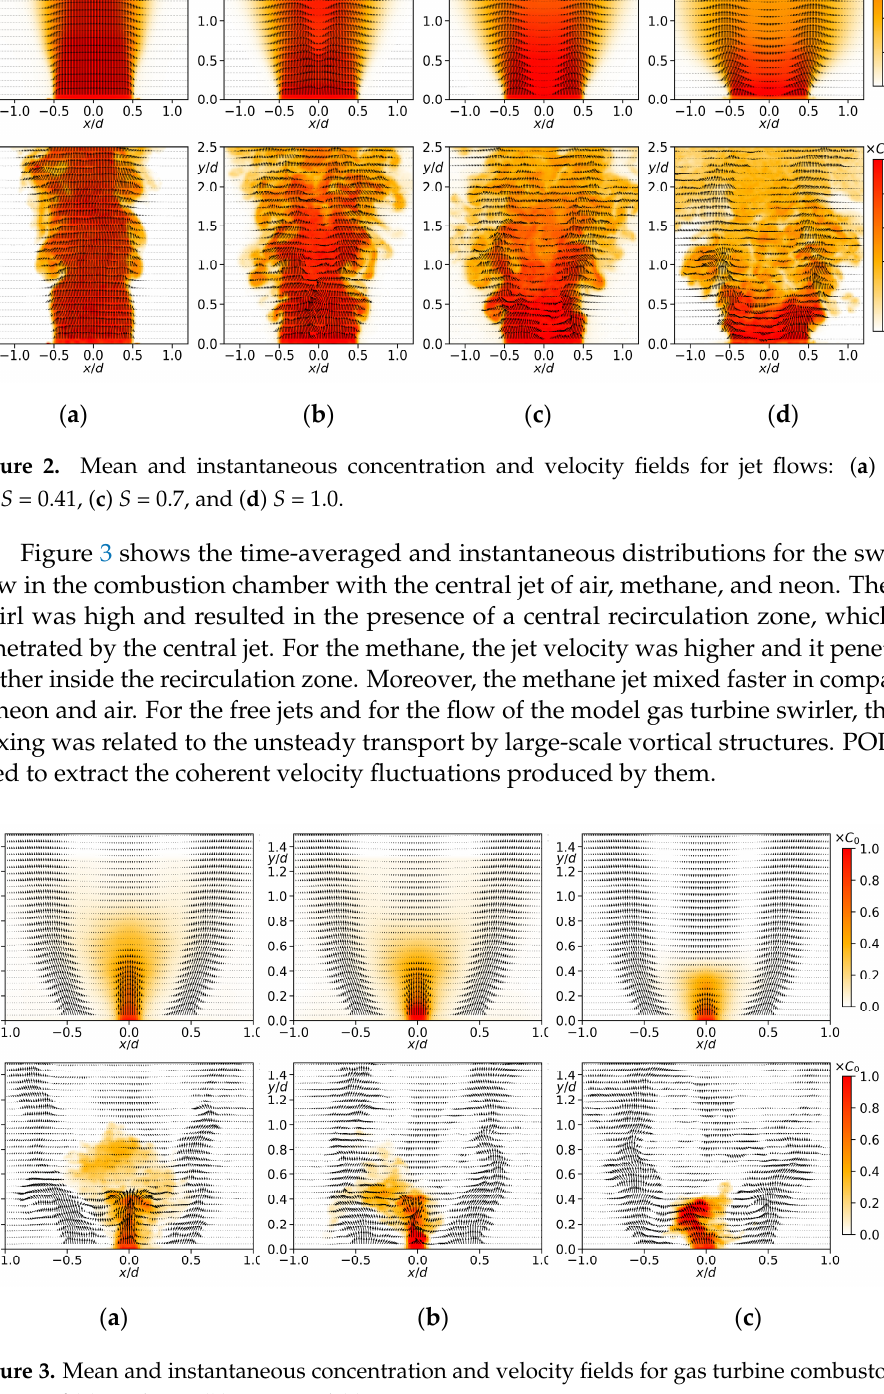
Figure 2. Mean and instantaneous concentration and velocity fields for jet flows: ( a ) S = 0, ( b ) S = 0.41, ( c ) S = 0.7, and ( d ) S = 1.0.